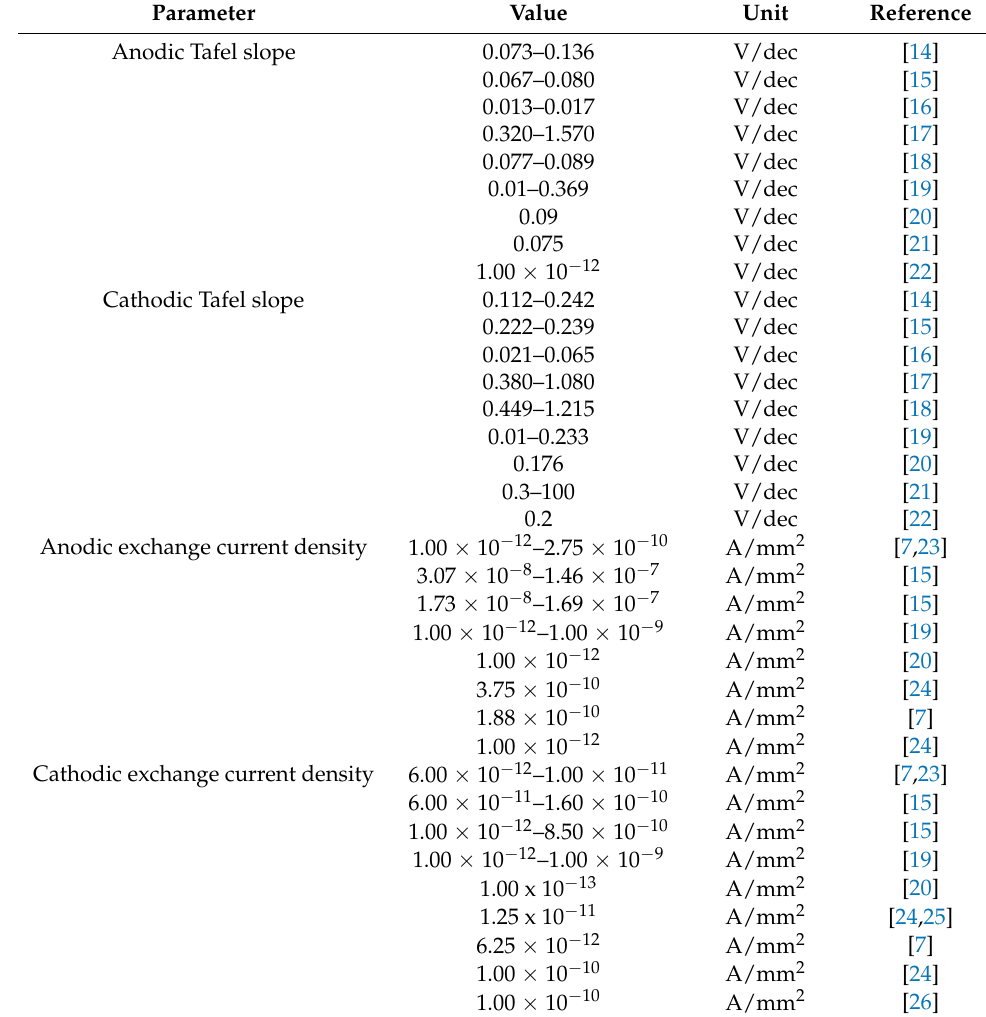
Table 1. Summary of Tafel slopes and current densities found in the